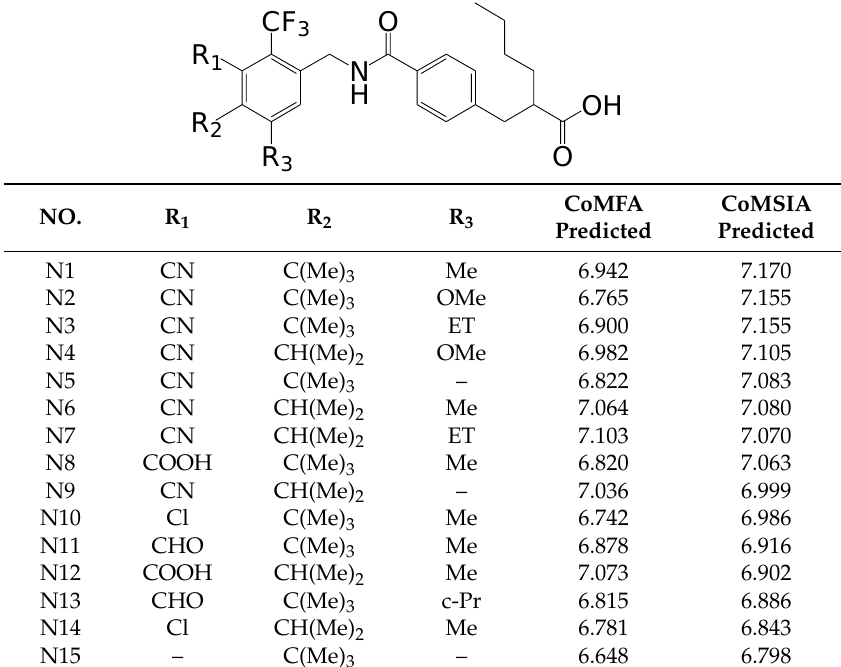
Table 2. Newly designed compounds and predictive activity.